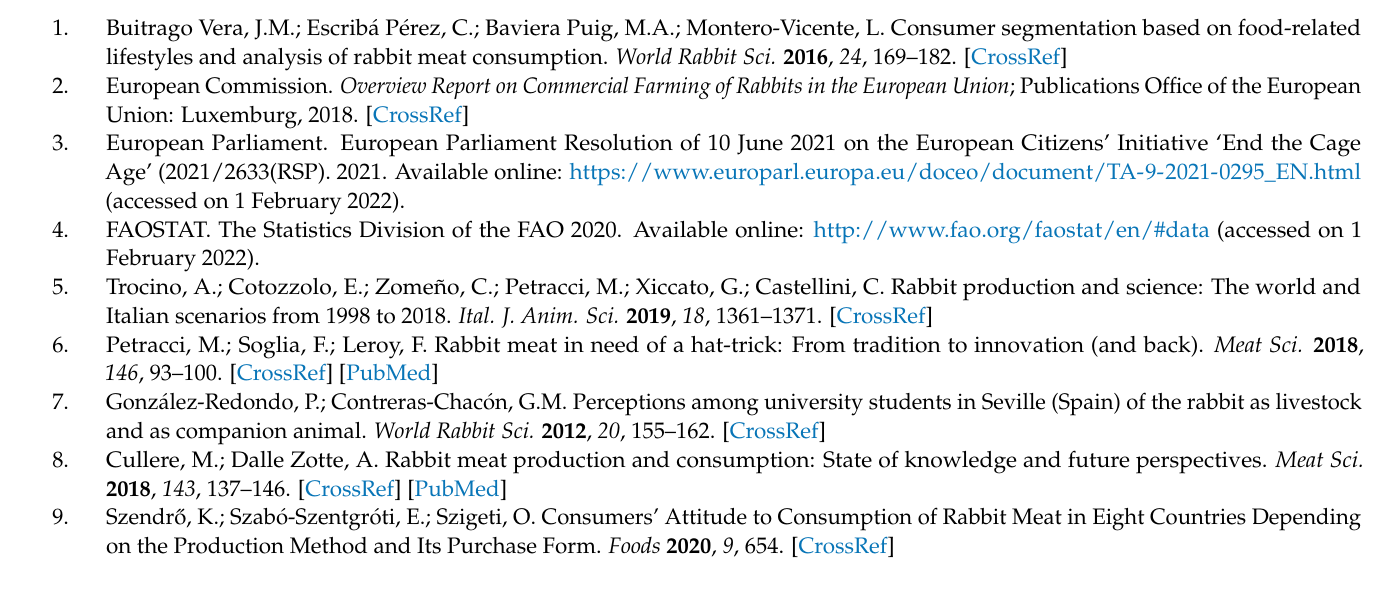
Figure A2. The word translation of the 5 clusters as reported in Figure 6.